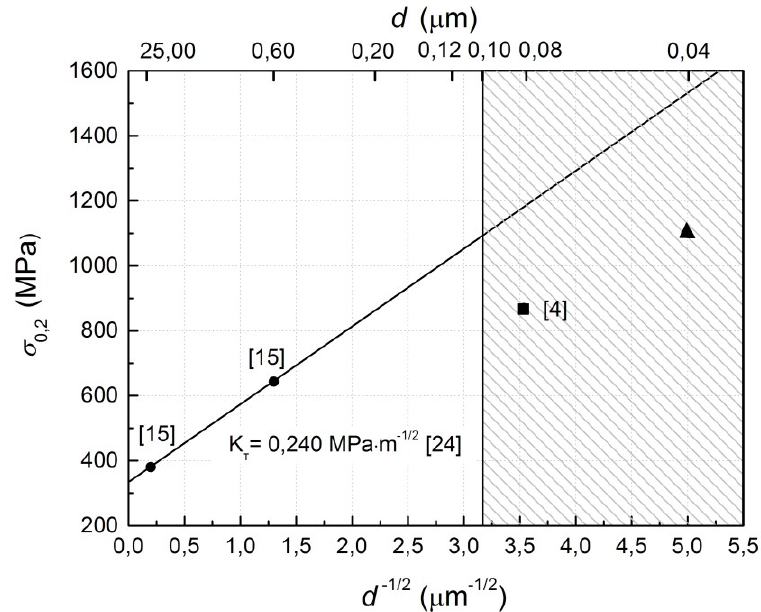
Figure 5. The relationship between grain size and yield stress (σ 0.2 ) and the experimental values for commercially pure (CP) Ti Grade 2 from earlier [4,15] and present